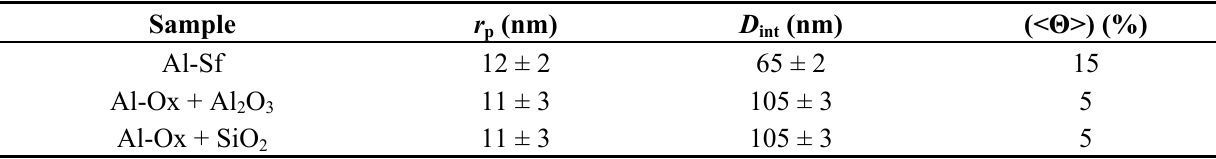
Table 1. Morphological parameters characteristic of the studied NPAMs: pore